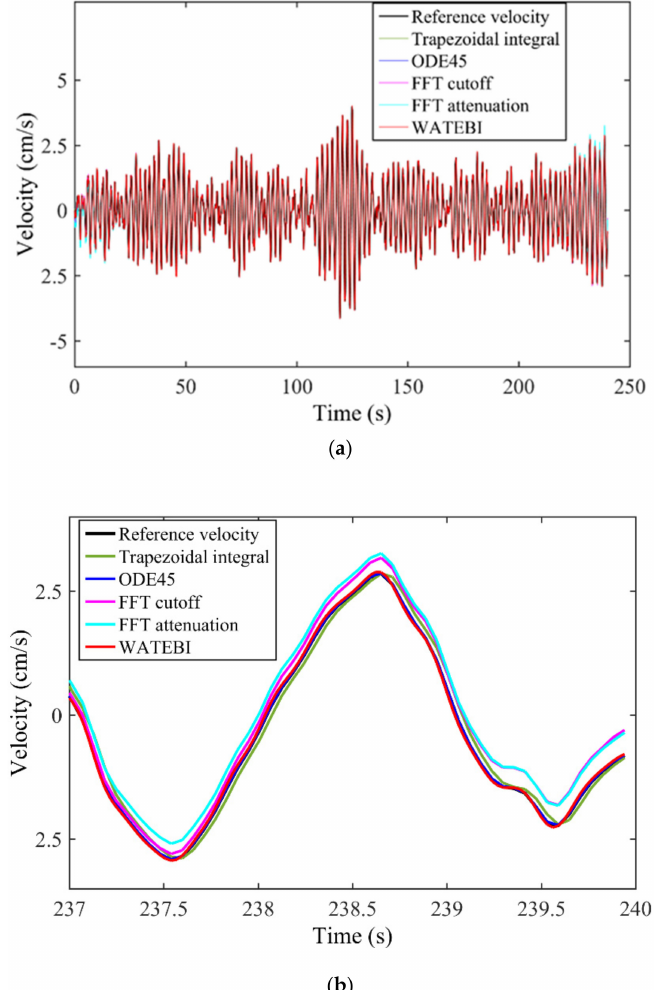
Figure 5. Velocity of the SDOF system: ( a ) Full duration; ( b ) Enlarged detail at the tail